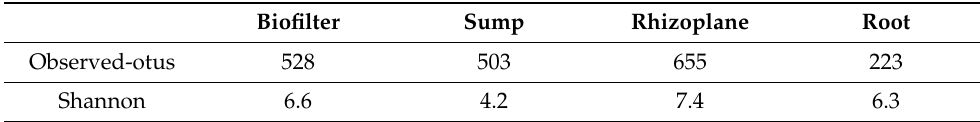
Table 1. Observed-otus and Shannon indices for each compartment.